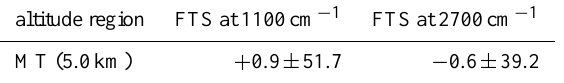
Table 6. Relative differences between our IASI and FTS δ D data